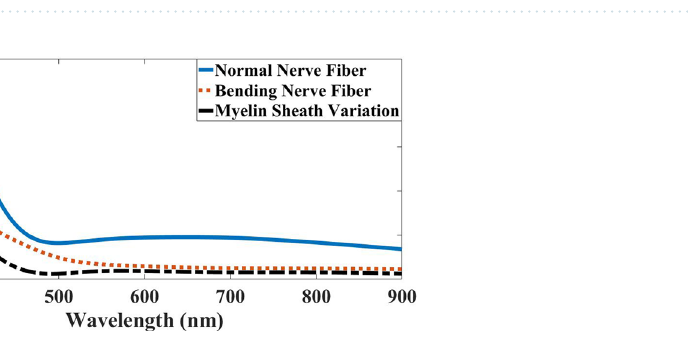
Figure 14. Distribution of the electric field of the myelinated axon while light is launched to the axon with ( a ) nerve fiber with bending, and ( b ) nerve fiber with myelin sheath variation.